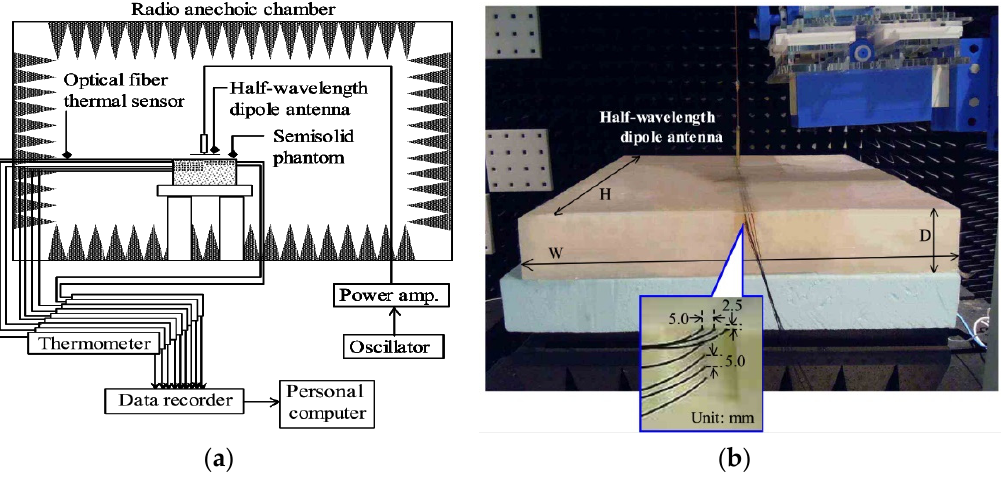
Figure 11. Thermal evaluation system for specific absorption rates: ( a ) system diagram, and ( b ) rectangular box-shaped semisolid phantom used for the measurements [109].